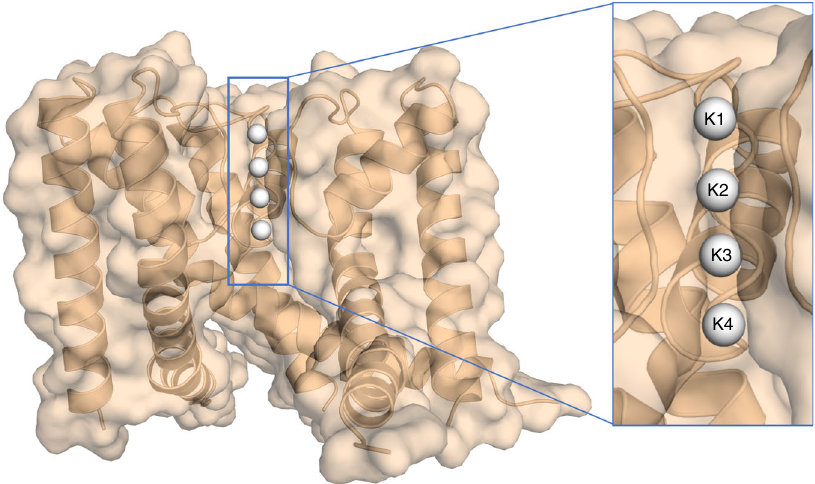
Fig. 1 Structure of the NaK2K ion channel protein. The four integral K + binding sites within the ion channel of a K + selective NaK2K (NaK D66Y and N68D) at a K + ion concentration of 100 mM are shown as white spheres. For clarity one of the four subunits that make up the ion channel has been removed